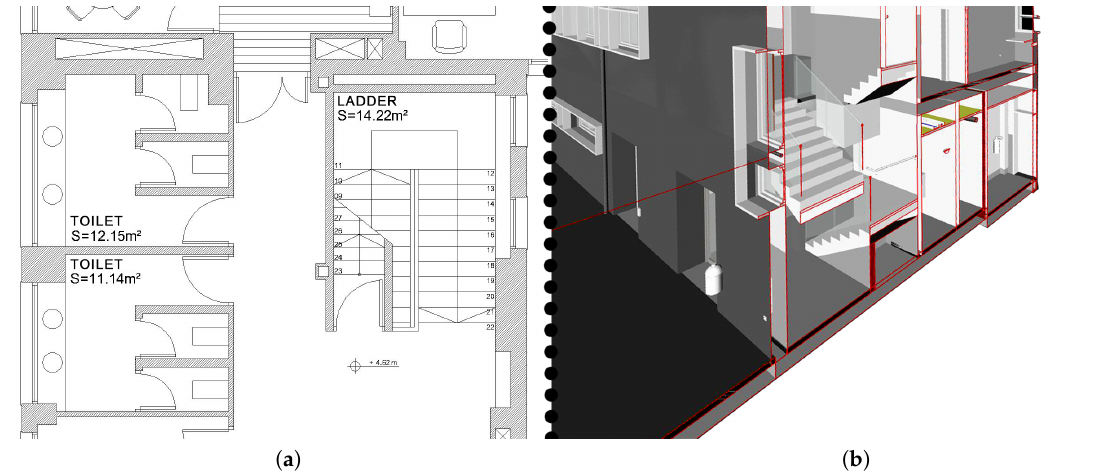
Figure 5. Window-sta irs conflict ( a ) 2D display di ffi culty and ( b ) easy detection in the BIM model.